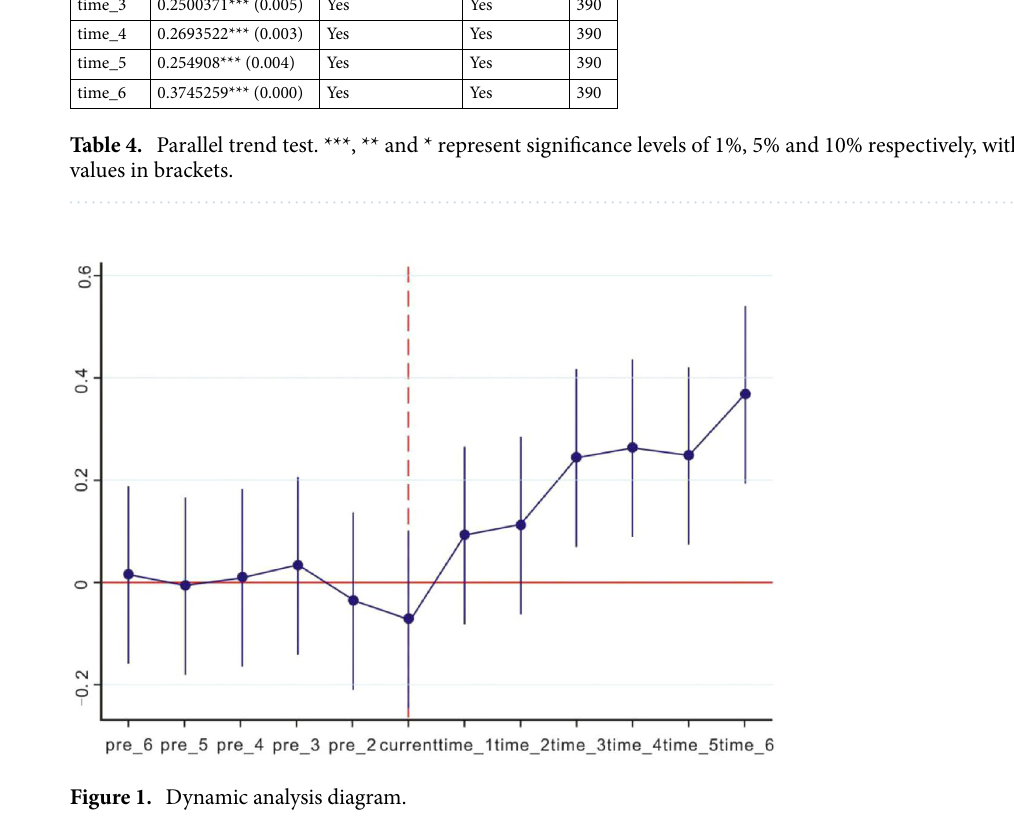
Figure 1. Dynamic analysis